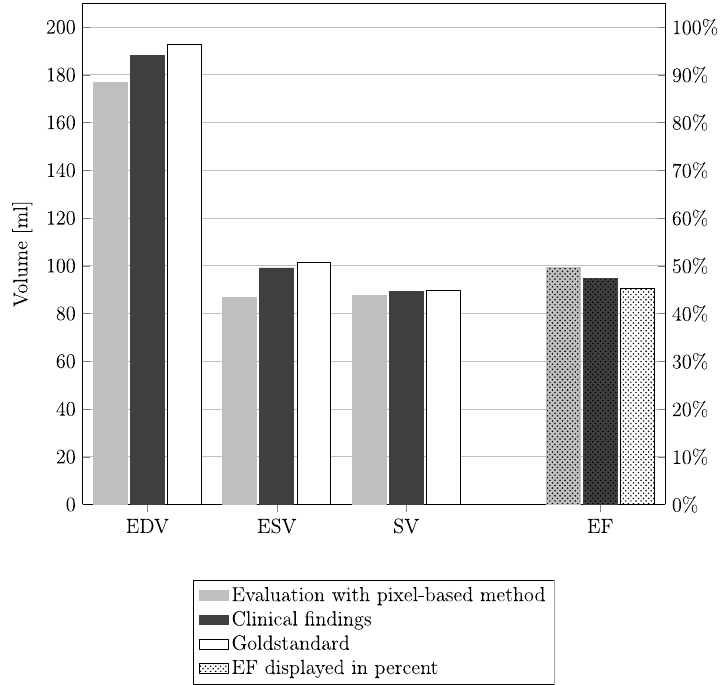
Figure 4. Mean values of the parameters EDV (=end-diastolic volume), ESV (=end-systolic volume), SV (=stroke volume) and EF (=ejection fraction) of all datasets ( n = 208) using the pixel-based method (grey columns), the conventional contour surface method (black columns) and the gold standard (white columns). y -axis: volume [mL].